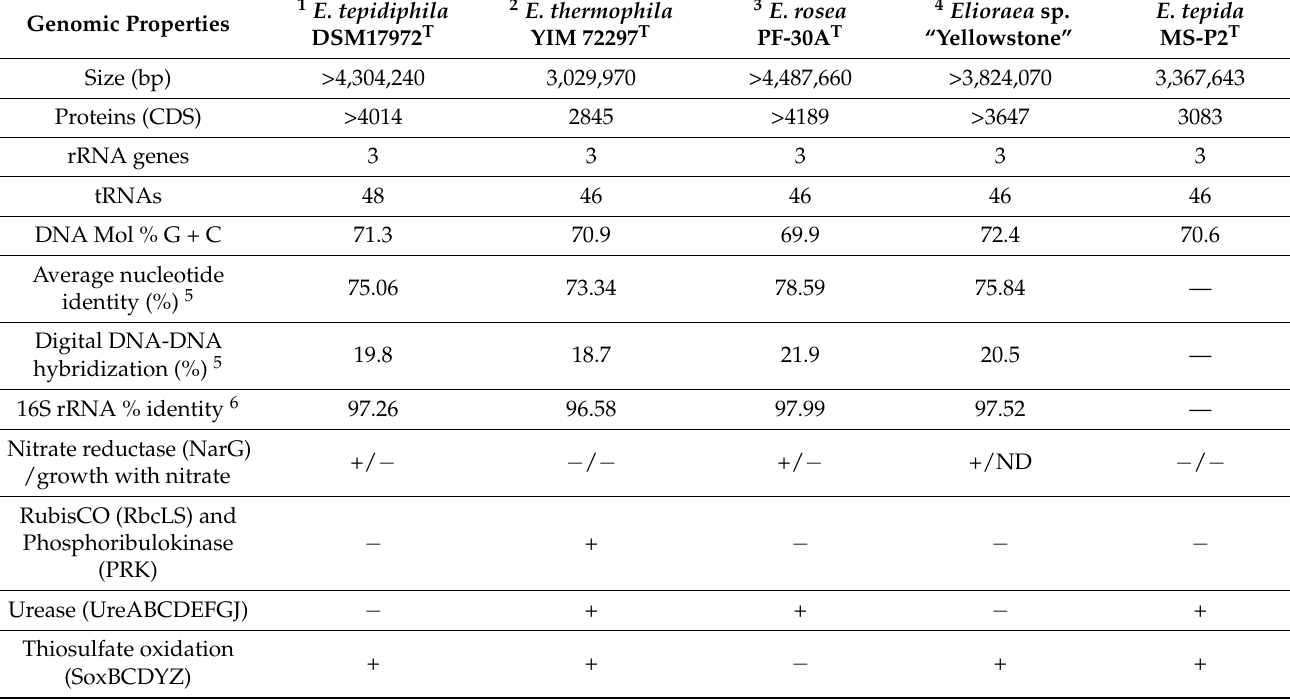
Table 3. Selected genomic characteristics of strains and species in the genus Elioraea